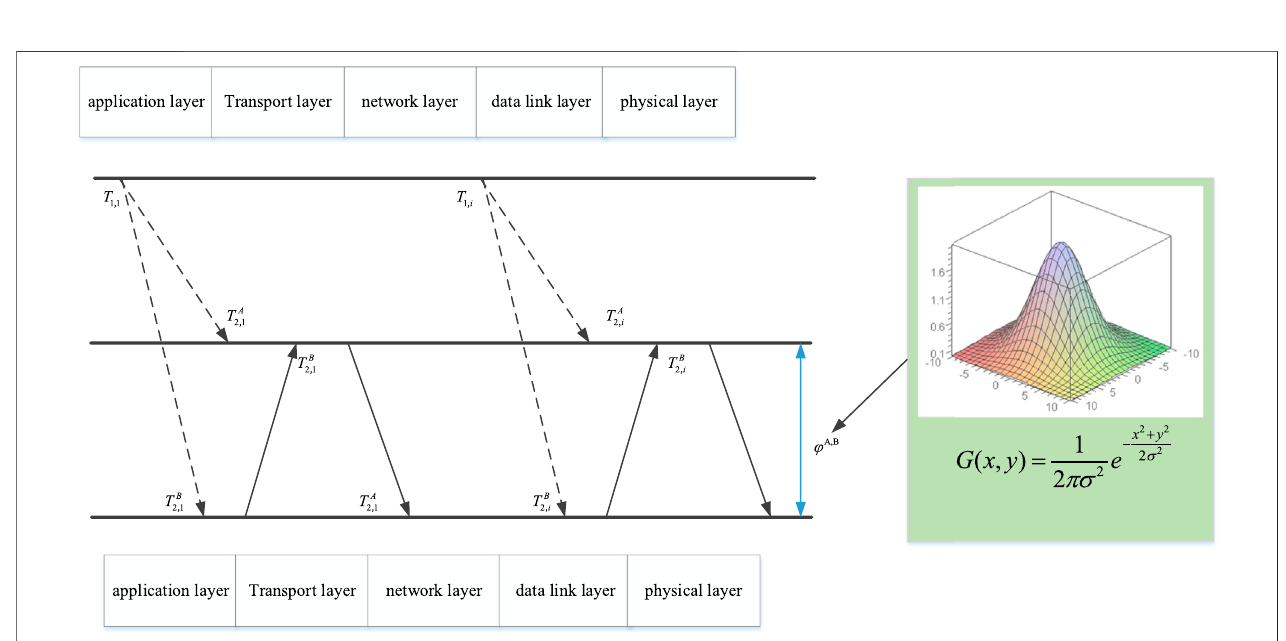
FIGURE 2 | RRS model considering the Gaussian distribution delay.